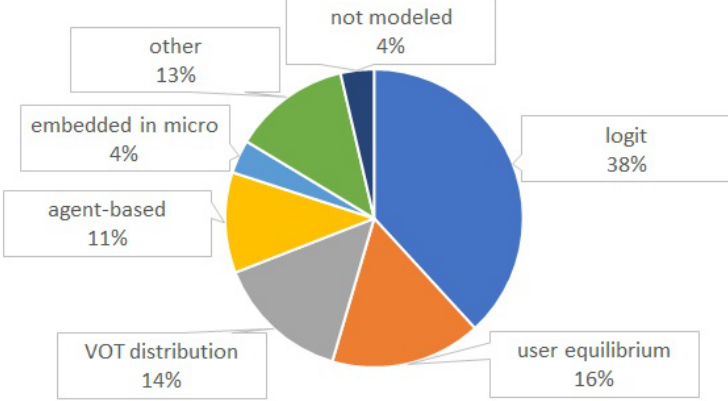
Figure 6. The distribution of the analyzed studies sorted by driver behavior model.